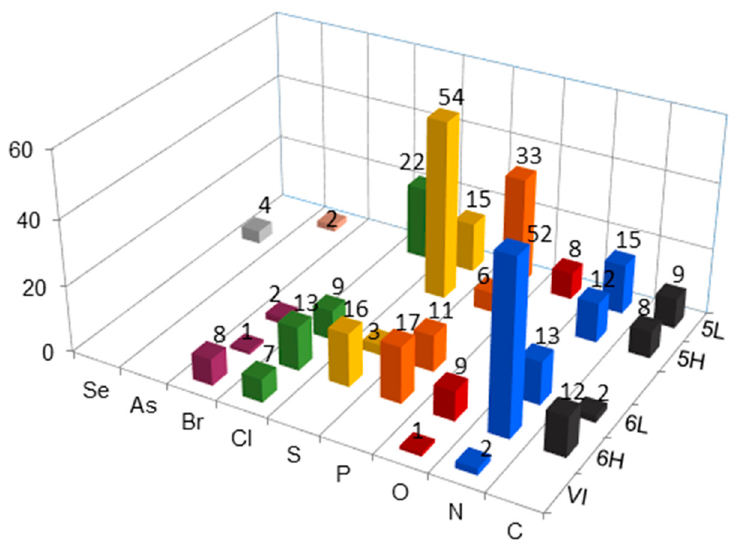
Figure 2. Contacting atoms versus oxidation number, coordination number, and complex symmetry. 5L, 5H, 6L, 6H = low and high five-coordinated and six-coordinated Tc V –complexes, respectively; VI = five- and six-coordinated Tc VI –complexes.